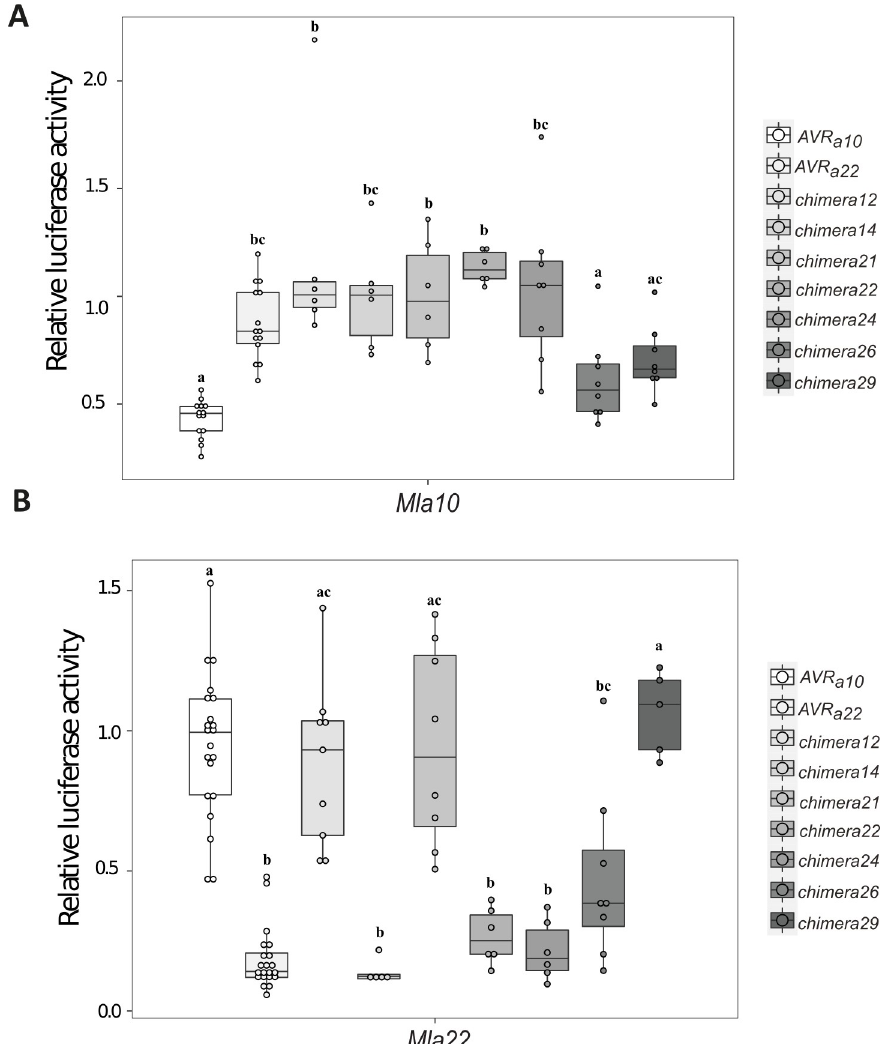
Fig 9. Co-expression of a selection of AVR A10 /AVR A22 chimeras with MLA10 and MLA22 in barley protoplasts. Barley protoplasts of cv . Golden Promise were co-transfected with a LUC reporter assay and pIPKb002 vectors containing cDNAs of AVR , AVR , chimera12 , chimera14 , chimera21 , chimera22 , chimera24 , chimera26 or a10 a22 chimera29 without signal peptide or with an empty vector (EV) together with either (A) Mla10 or (B) Mla22 in pipkb002. Transfections were performed at least six times independently. Significant differences between samples were analyzed using non-parametric Kruskal-Wallis (KW) analysis followed by the Dunn’s test. Calculated KW p -value are as follows: Mla10 : p = 1.439e-07, Mla22 : p = 5.374e-11. Samples labeled with different letters differed significantly ( p < 0.05) in the Dunn’s test.